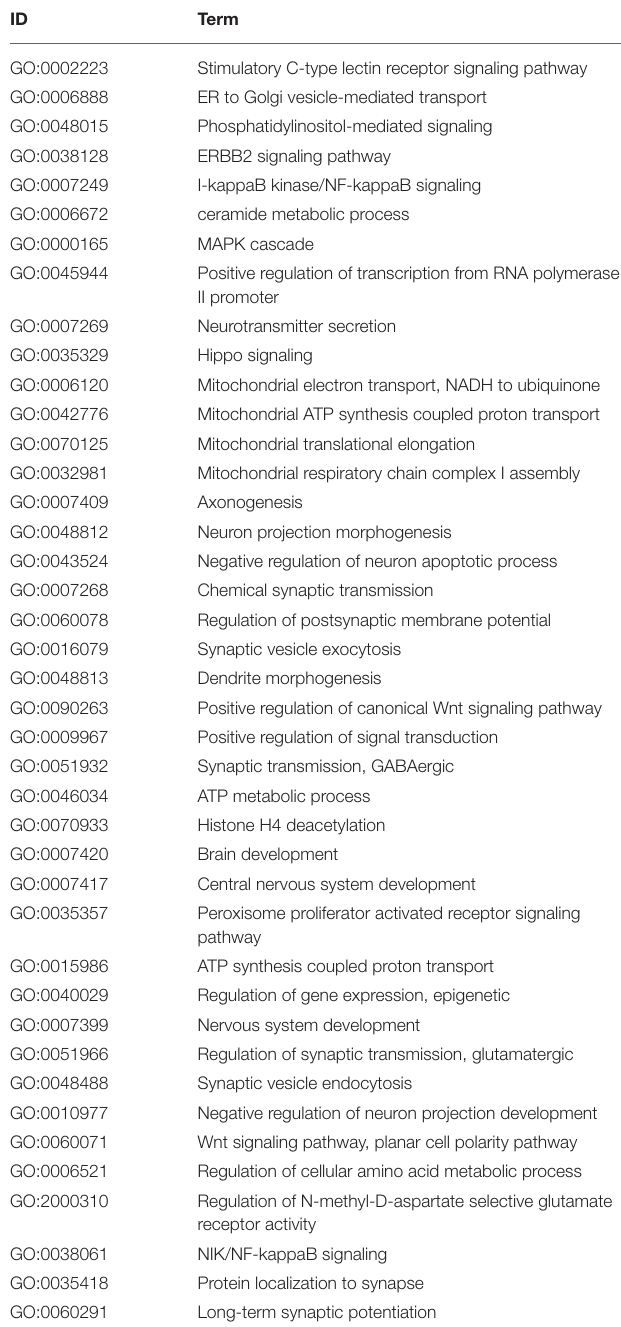
TABLE 3 | Significant GO terms obtained from DAVID ( P <